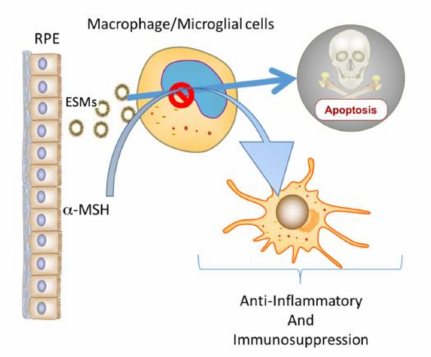
Figure 5. The potential role of ESMs and α -MSH produced by RPEs in ocular immune privilege. Within the immune-privileged eye, RPEs constitutively produce α -MSH and release ESMs. The results demonstrated that ESMs induce apoptosis in macrophages and that α -MSH suppresses the apoptotic signal. Previous publications have shown that α -MSH induces anti-inflammatory and suppressor activity in macrophages. Therefore, this combination of RPE ESMs and α -MSH could act as a selective mechanism that permits the survival of only macrophages and resident microglial cells that act to maintain the anti-inflammatory microenvironment of the